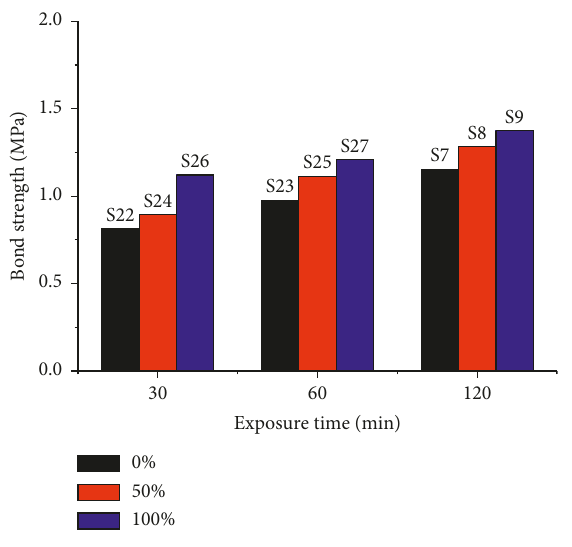
Figure 8: Effect of length-to-width ratio on bond strength.